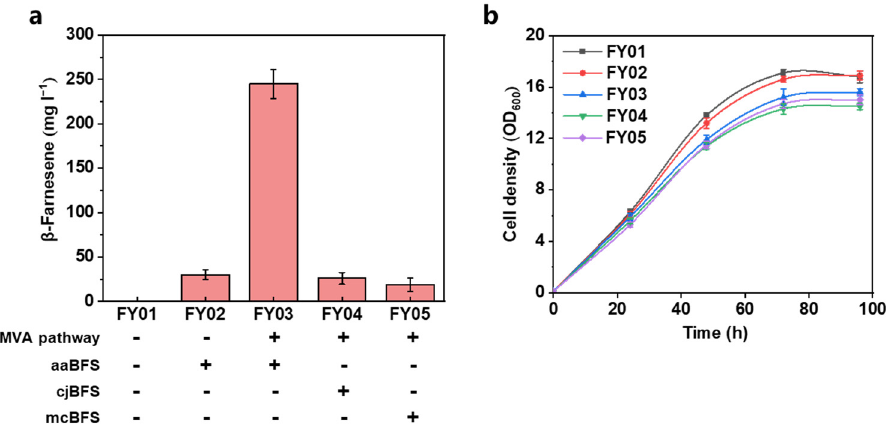
Figure 2. Construction of β -farnesene synthesis strain by overexpression of MVA pathway and β -farnesene synthase. Effect of expression of MVA pathway genes aaBFS , cjBFS , and mcBFS in strain FY01 on ( a ) β -farnesene production and ( b ) cell density. β -Farnesene was detected at 96 h of fermentation. Data are represented as mean ± standard deviation (n = 3).